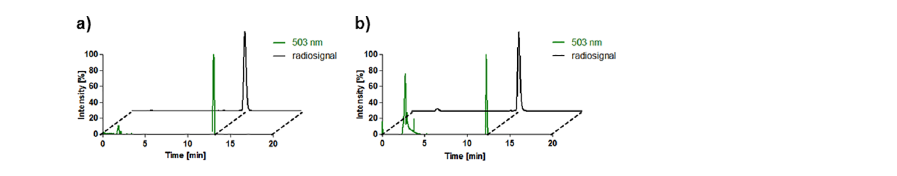
Fig 2. Chromatograms for BDP-FA/TG a HPLC chromatograms (radio trace and absorbance at 503 nm) of 18 F-BDP-FA 3 on a C18 column. b HPLC chromatograms (radio trace and absorbance at 503 nm) of 18 F-BDP-TG 4 (peak at 3 min corresponds to toluenewhich was used to solubilizethe probe) on a C4 column.